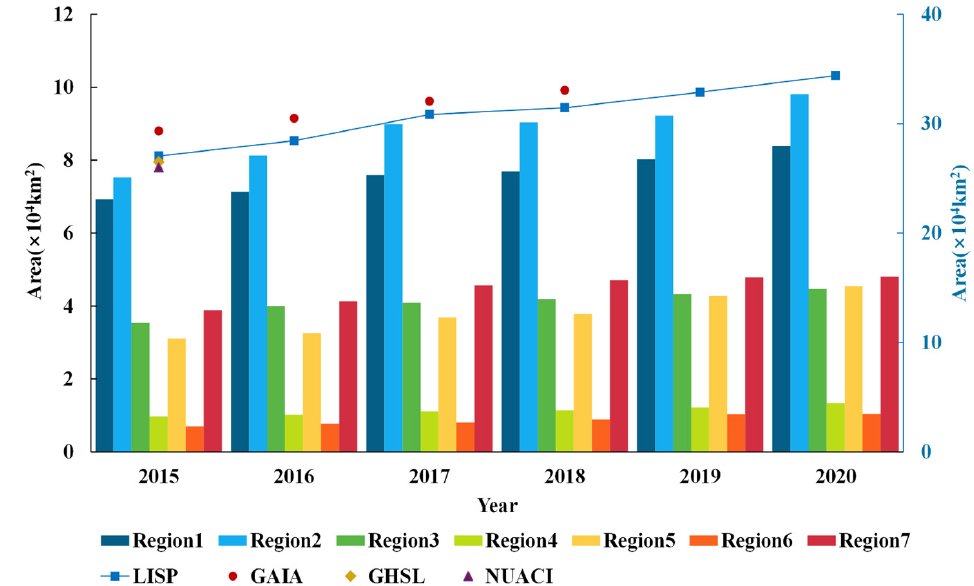
Figure 9. Annual impervious surface areas in Asia from 2015 to 2020.